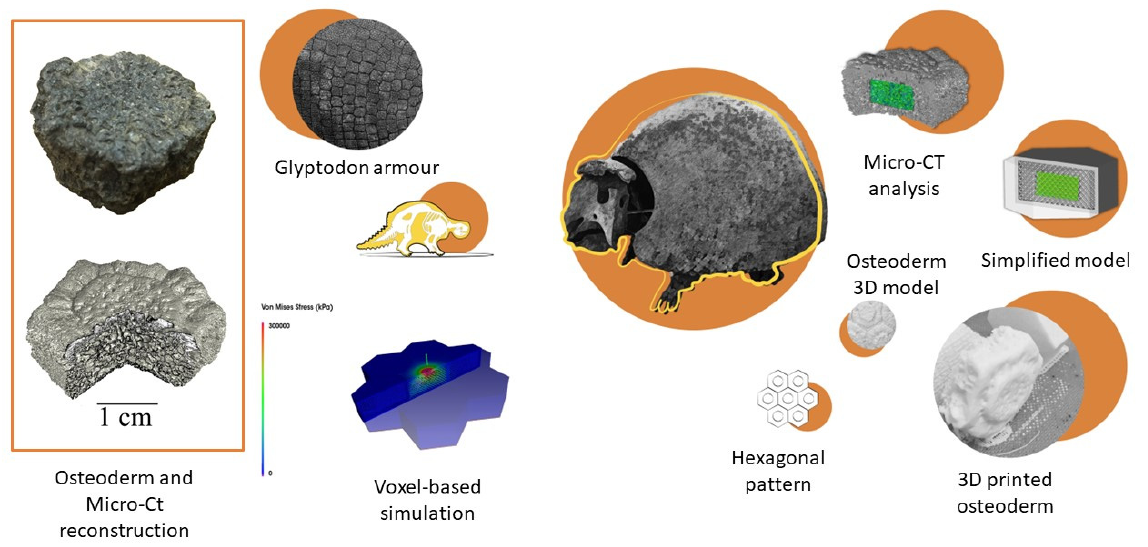
Figure 3. Virtual palaeontology: Micro-CT scan, reconstruction, analysis, and 3D printing. The Glyptodon osteoderm structure was reconstructed, analysed using FEA and recreated in simplified reverse engineered models to be mechanically tested. Graphical representation: Carmen Cerere. Images courtesy of Chris Broeckhoven, European Space Agency, ACT, Netherlands, and Anton du Plessis, Object Research Systems, Montreal, Canada.